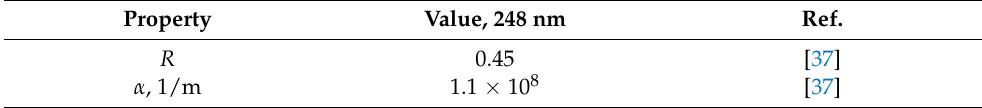
Table A16. Liquid -CdTe—optical